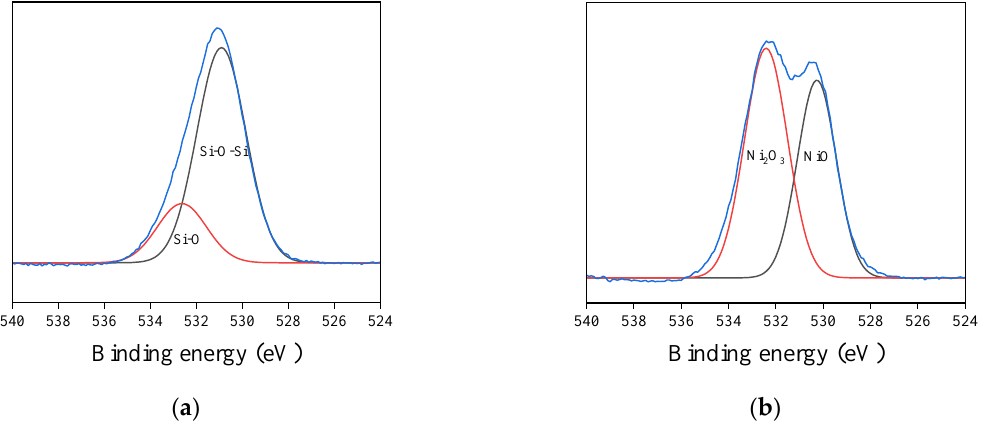
Figure 7. High-resolution XPS O 1s profiles of the ( a ) untreated glass fibers and ( b ) Ni-P plated glass fibers.